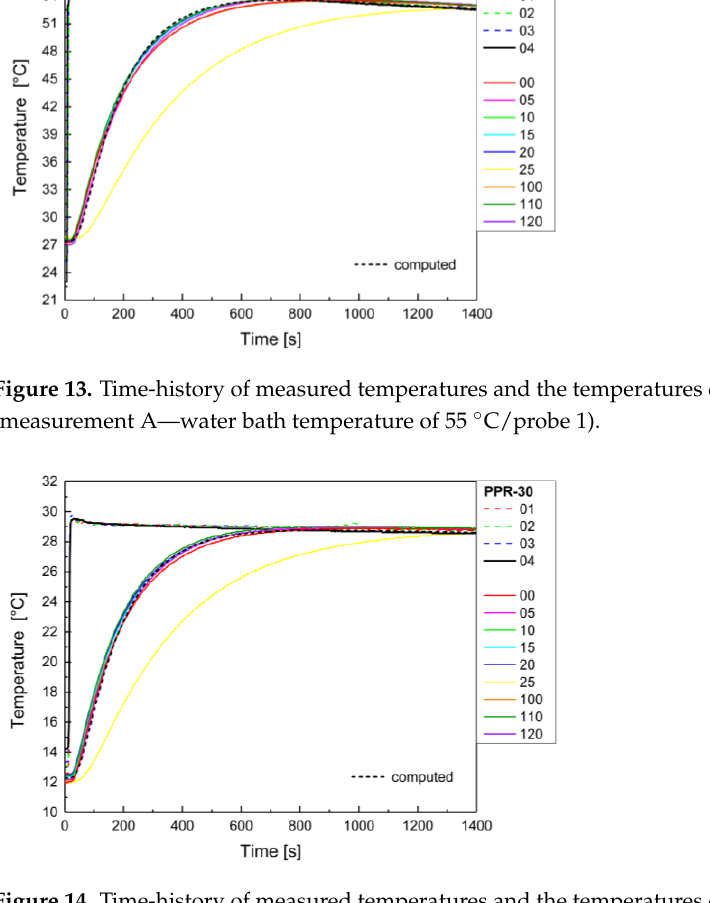
Figure 14. Time-history of measured temperatures and the temperatures computed in the probe axis (measurement A — water bath temperature of 30 °C/probe 1).